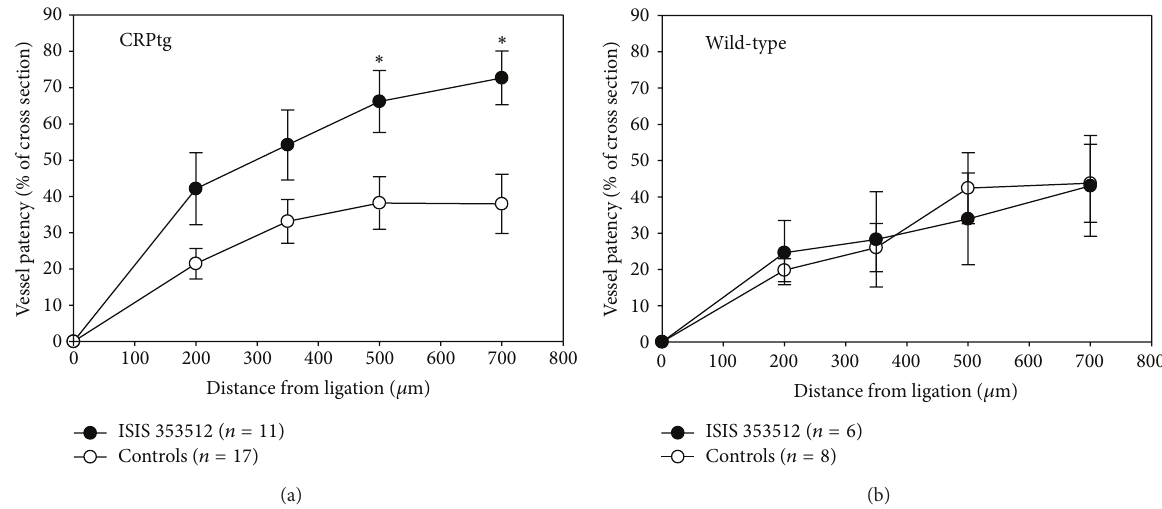
Figure5:TreatmentwiththehumanCRP-specificASOISIS353512improvesbloodvesselpatencyfollowingRCCAligationinCRPtgmice(a) but not in wild-type mice (b). Blood vessel patency was calculated as described in the Materials and Methods . The asterisks indicate ∗ 𝑃 < 0.05 for unpaired t